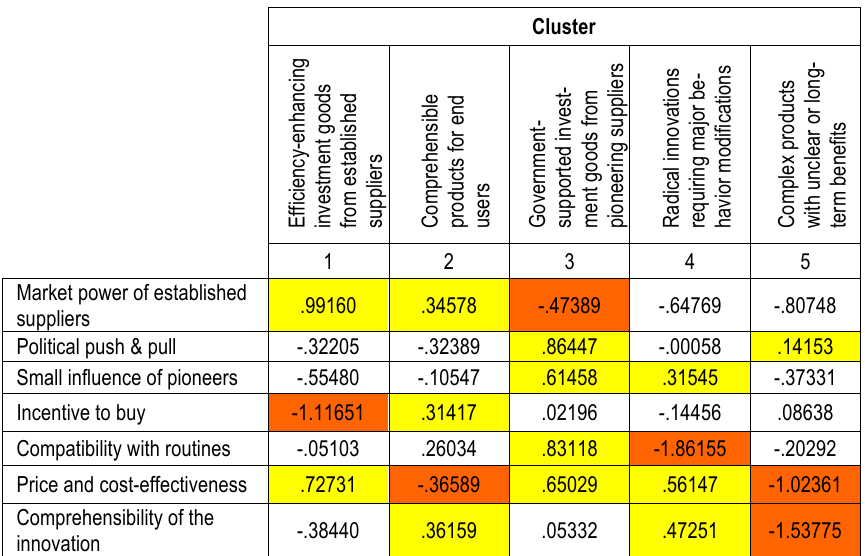
Table 6. Cluster